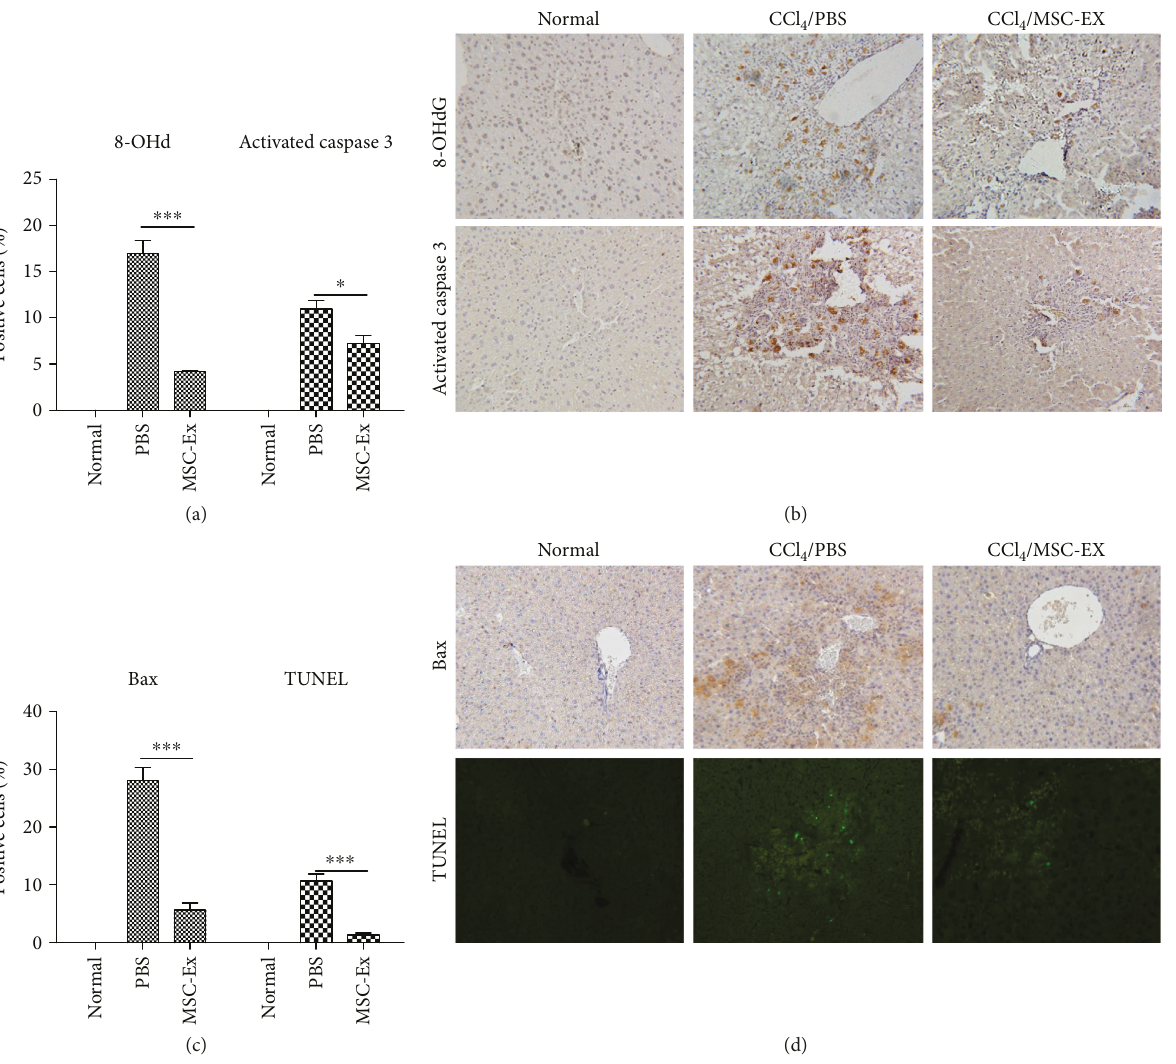
Figure 4: hucMSC-Ex reduced oxidative stress in acute liver injury. (a, b) Immunohistochemistry staining of 8-OHdG and activated caspase 3 in mouse livers. Reduced production of oxidative stress marker 8-OHdG and activated caspase 3 expression was detected in the hucMSC-Ex group ( n = 10 ; ∗ P < 0 05 , ∗∗∗ P < 0 001 ). Original magni fi cation 200x. (c, d) Immunohistochemistry staining of Bax and TUNEL in mouse liver slides. Bax expression and cell apoptosis were decreased in the hucMSC-Ex group ( n = 10 ; ∗∗∗ P < 0 001 ). Original magni fi cation